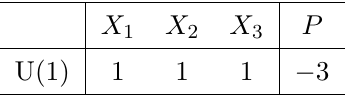
Table 5 . GLSM for local P 2